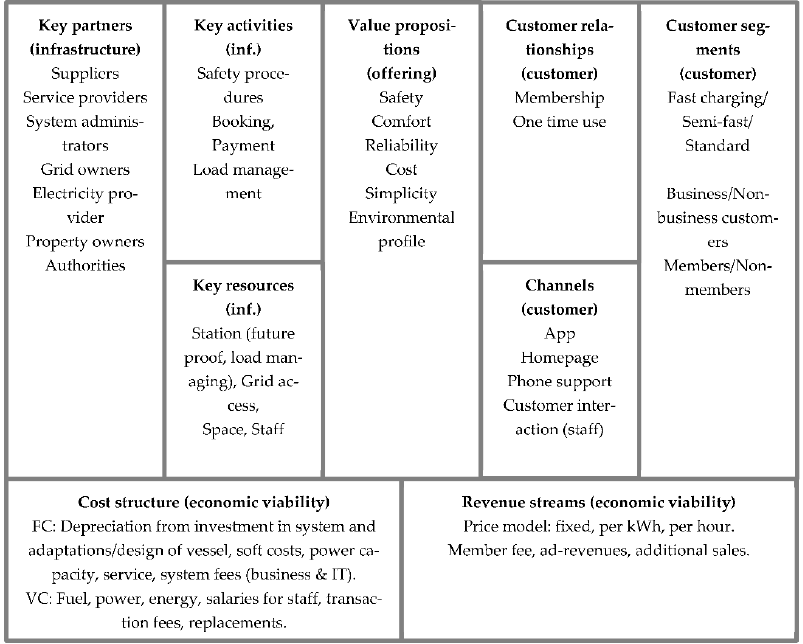
Table 4. Ferry operators’ marketing message for onboard charging.